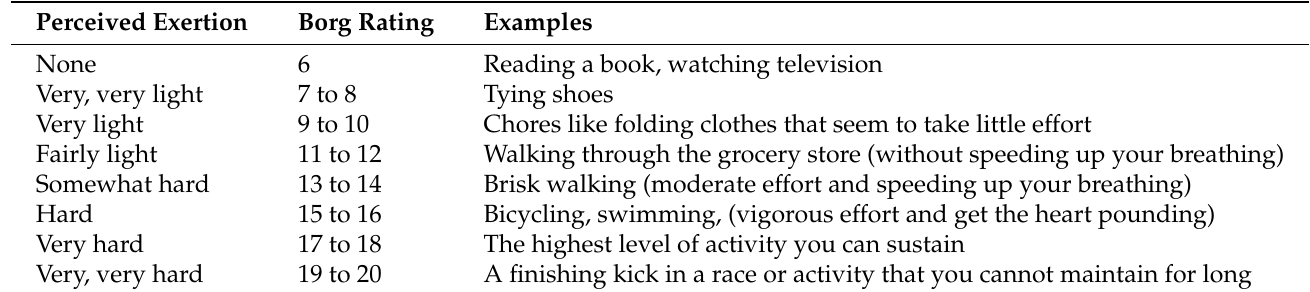
Table 1. Borg G.A. Psychophysical bases of perceived exertion [43].